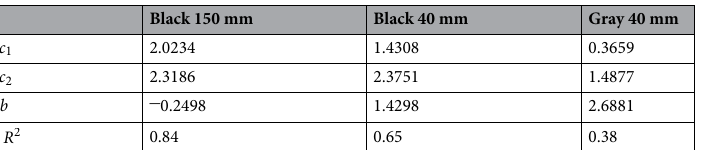
Table 1. Regression coefficients and R 2 values for the standard globe, black, and gray ping pong balls. The form of the regression equation is t r ( ◦ C )